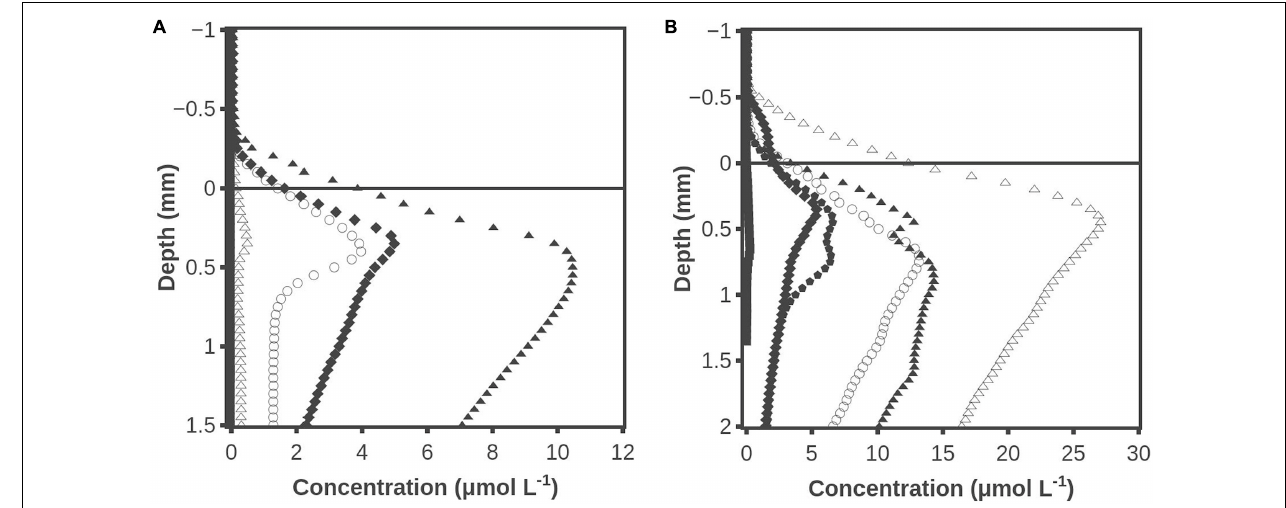
FIGURE 6 | (A) Hydrogen accumulation when the top ∼ 1 mm cyanobacterial layer of the mat was placed on agar. Time after darkening: 1 min ( (cid:4) ), 10 min ( (cid:7) ), 30 min ( (cid:78) ), 60 min